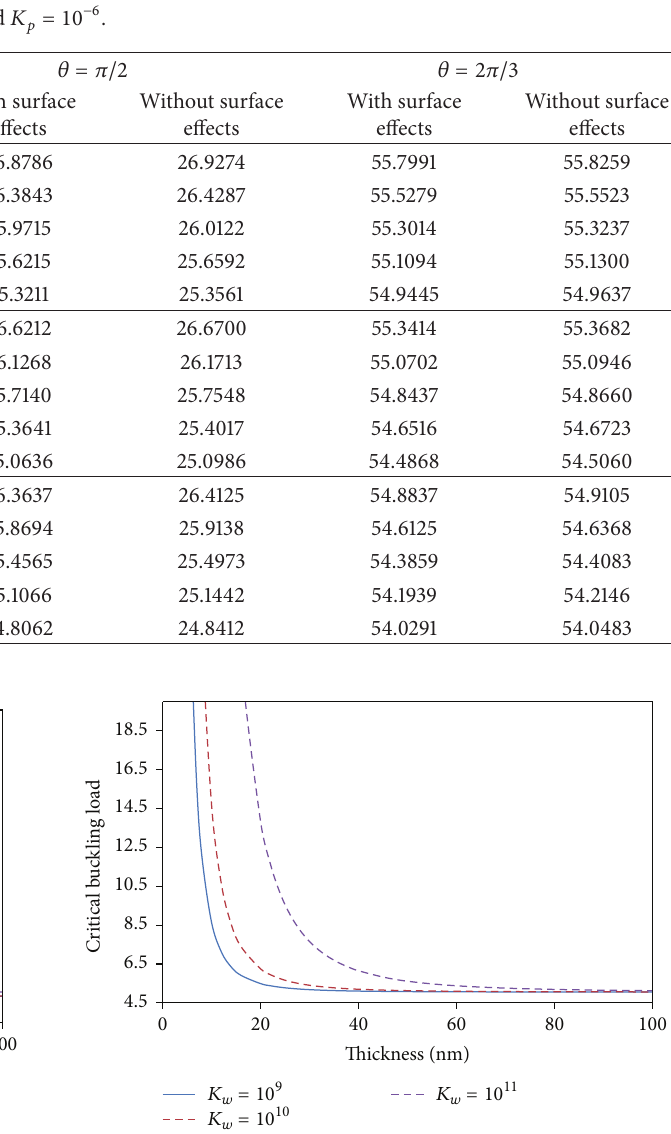
Table 4: Comparison of the dimensionless critical buckling loads of circular curved nanobeam with and without surface effects with various